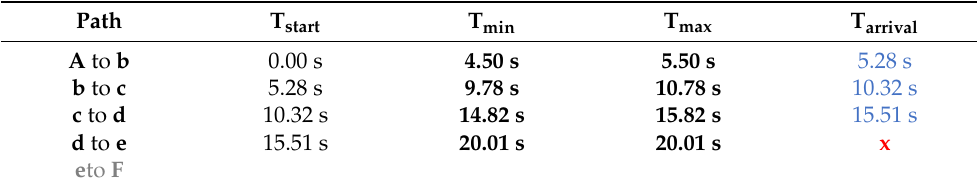
Table 4. The actual numerical time data including T start , T min , T max , and the actual arrival time T arrival for the air-collision case. For the first three intervals from A to d it arrived inside the time-window. However, due to the motor failure after waypoint d, the drone struggled to return to its mission path and exceeded the maximum time-window. This type of emergency is extremely dangerous, yet hard to handle. Path T start T min T max T arrival A to b 0.00 s